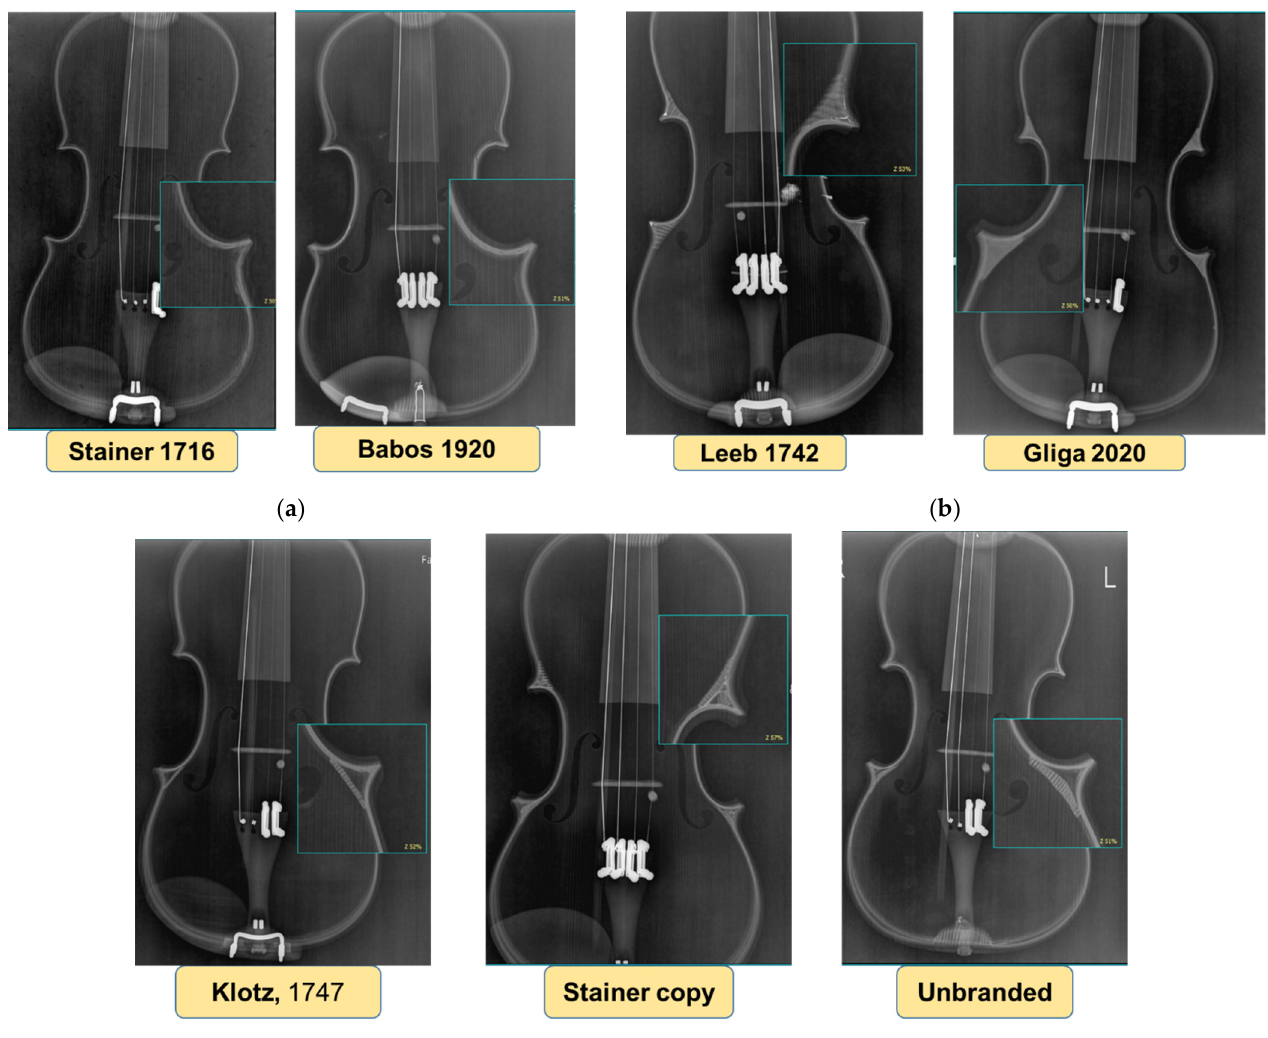
Figure 9. The constructive shape of corners visible on X-ray radiation: ( a ) Violins without corners; ( b ) Violins with solid wood corners; ( c ) Violins with softwood slates.